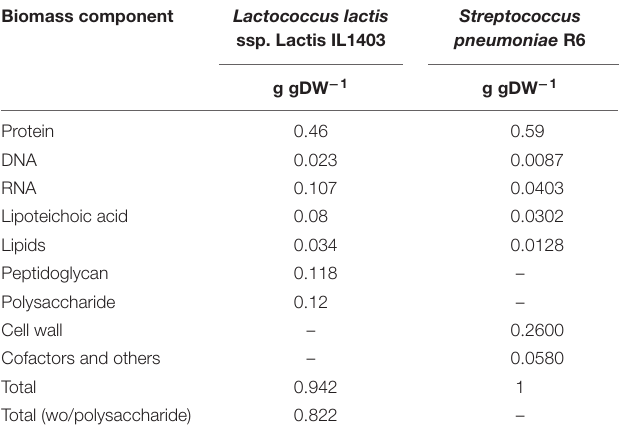
TABLE 3 | Biomass macromolecular composition of the model i DS372 from Streptococcus pneumoniae R6 and comparison with biomass from iAO358 Lactococcus lactis ssp. Lactis